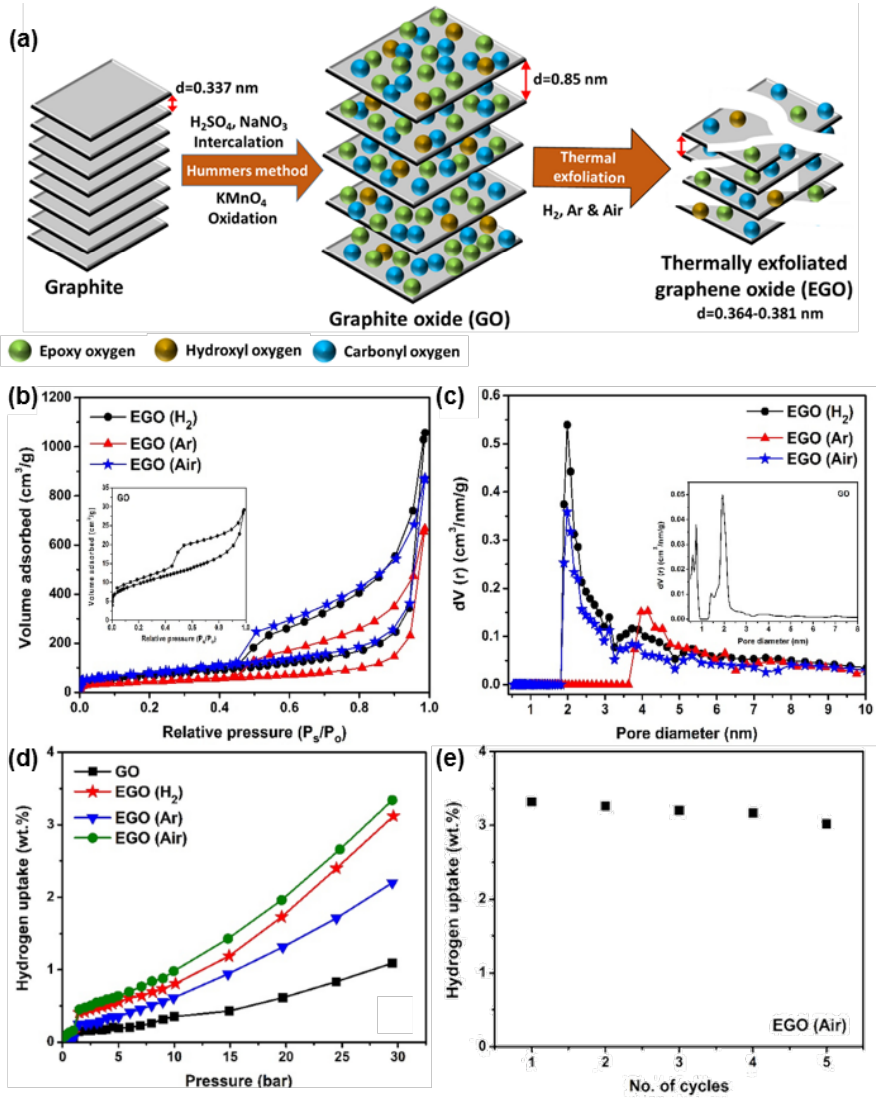
Figure 9. ( a ) Preparation process of thermally exfoliated graphene oxide (EGO) under various gas conditions, ( b ) N 2 adsorption–desorption isotherms, ( c ) pore size distributions, ( d ) hydrogen uptakes at 77 K and 30 bar, and ( e ) cycle stability for hydrogen uptake under 5 cycles. Reproduced from ref. [130]; copyright (2021) with permission from Springer.